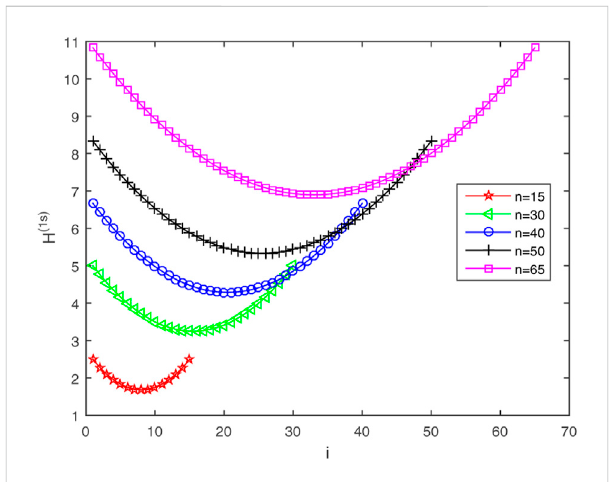
FIGURE 2 The relationship between the coherence of G s and the edge connection position